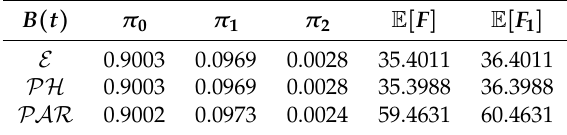
Table 5. Case 5: π i , i = 0,1,2, E [ F ] and E [ F 1 ] , A ∼ LN ( µ , σ ) versus B ( t ) . B ( t ) π 0 π 1 π 2 E [ F